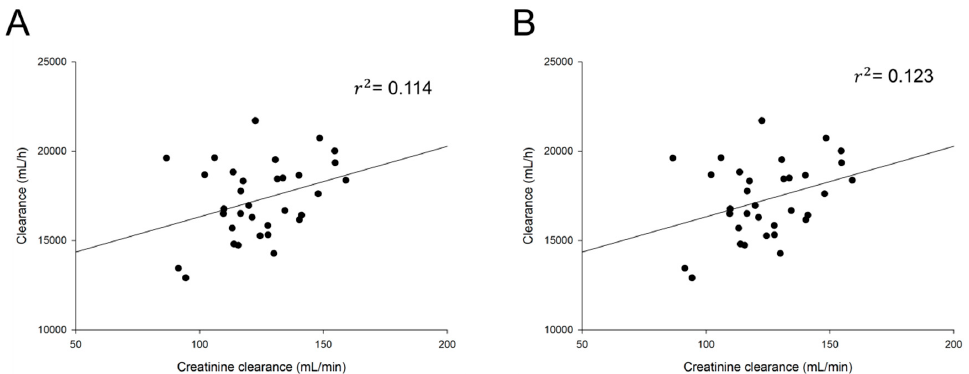
Figure 1. Relationship between individual predicted pharmacokinetic parameters and subject‘s characteristics. ( A ) Clearance of total cefprozil according to creatinine clearance; ( B ) Clearance of cis -cefprozil according to creatinine clearance.